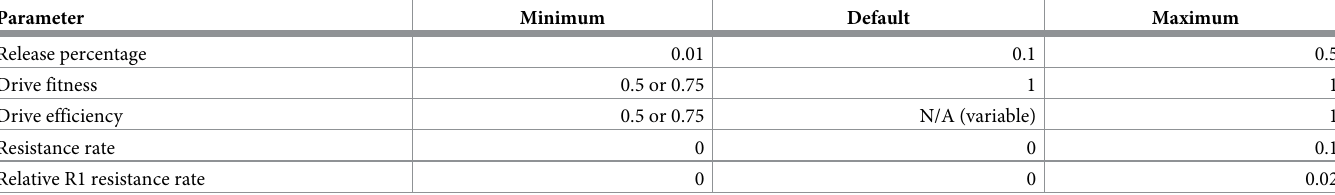
Table 2. Gene Drive